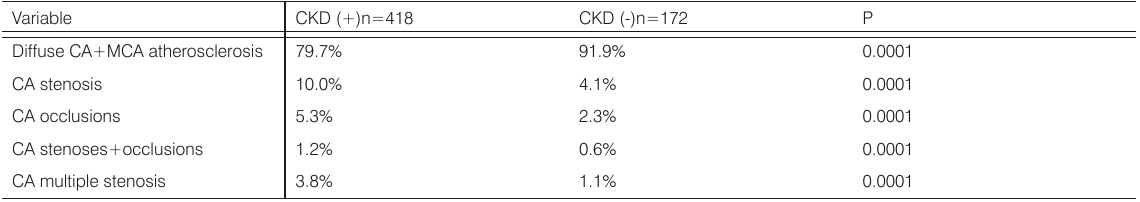
Table 2. Types of cerebral vascular lesions in CKD (+) and CKD (-) patients.